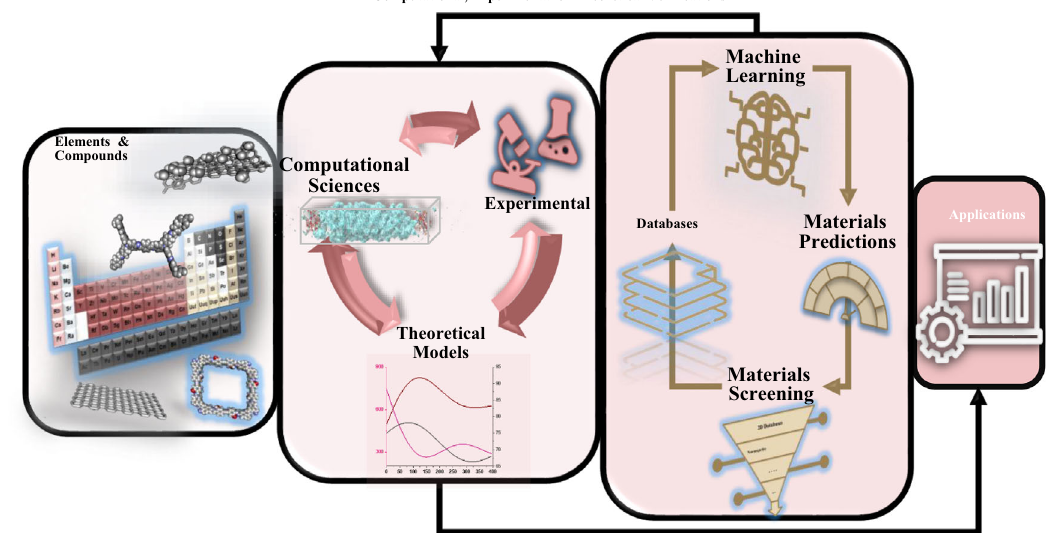
Fig. 5 Using computational and experimental data for Ai-based material discovery. Computational chemistry can improve the datasets used in material discovery with theoretical studies, and along with the properties that can be observed in the laboratory, atomic properties (which can be studied in computational chemistry) can also be entered into the dataset. In this way, the accuracy and reliability of the AI-based material discovery will increase 92